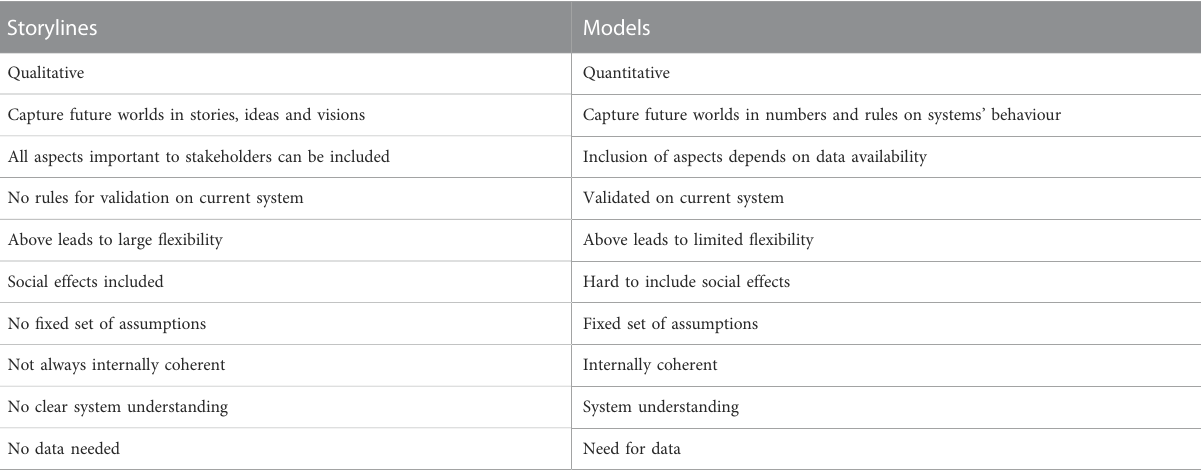
TABLE 1 Characteristics of storylines and